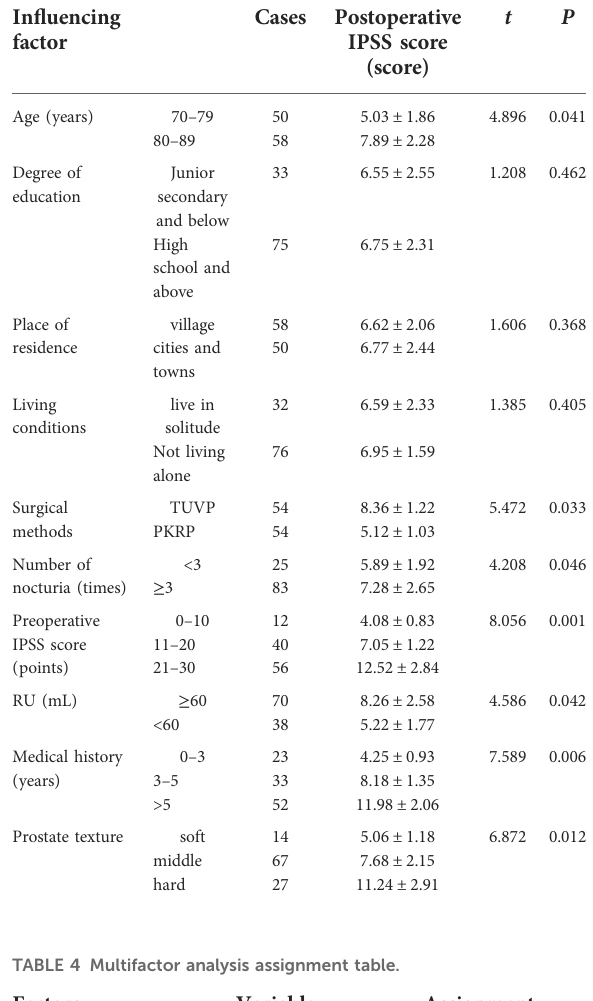
TABLE 3 Univariate analysis of the postoperative condition (IPSS score) of BPH patients.